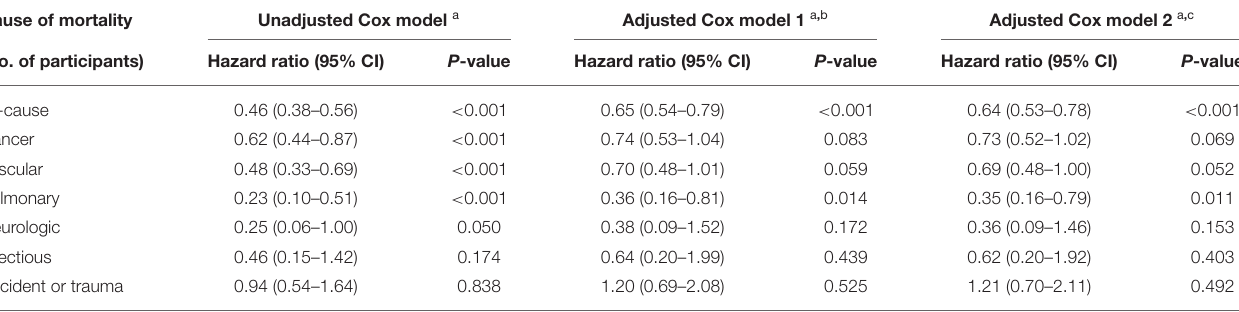
TABLE 4 | Hazard ratios for all-cause and cause-specific mortality in elderly patients with macular diseases stratified by vitrectomy status. Cause of